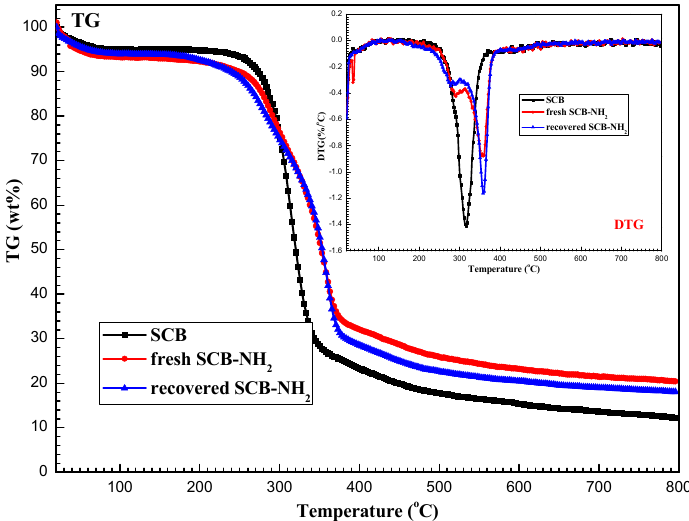
Figure 3. Thermal decomposition profiles of SCB, fresh SCB-NH 2 , and recovered SCB-NH 2 .